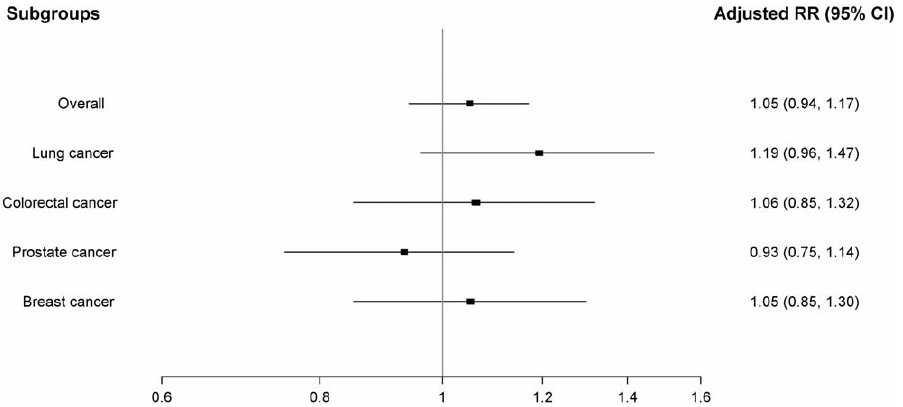
Figure 3. Adjusted rate ratios of specific cancers associated with use of angiotensin receptor blockers in combination with angiotensin-converting enzyme inhibitors relative to the use of diuretics or beta-blockers.